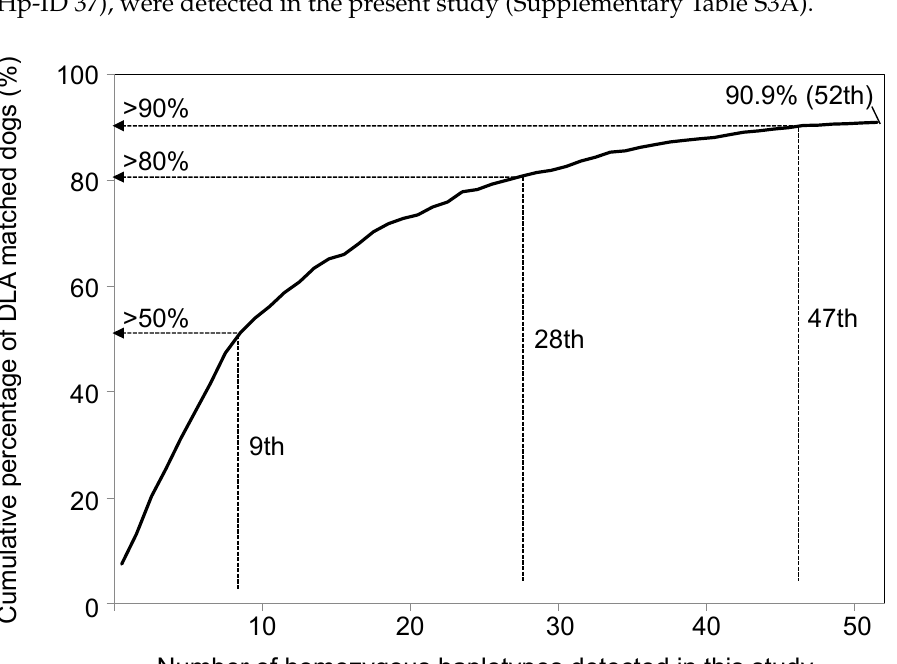
Figure 7. The cumulative percentage of dogs matched for homozygous 88-12/88L-DRB1 haplotypes detected in this study. The horizontal and vertical axes indicate 52 types of 88-12/88L-DRB1 homozygous haplotype numbers, which are sorted in descending order of the haplotype frequency, and the number of dogs, respectively. The cumulative proportion of dogs was calculated using the 803 dogs with identified haplotypes. Table 6. The percentage of the dogs with the most frequent haplotype within each breed.